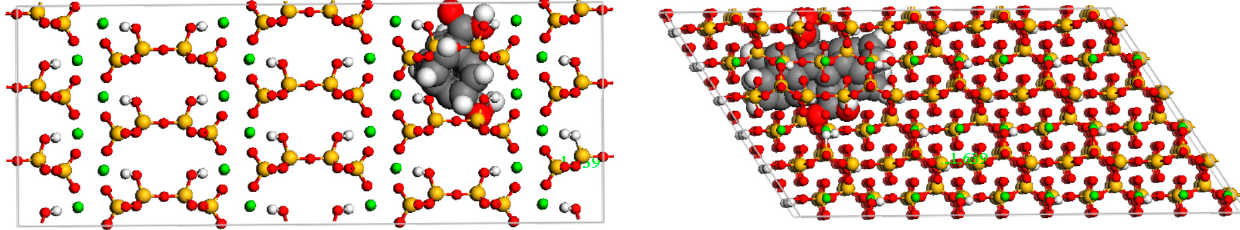
Figure 1. Side ( left ) and top ( right ) view of a SWCNT (2,2), which is functionalized with two COOH groups, embedded in a tobermorite crystal 11 Å. Red: oxygen, Yellow: silicon, Green: calcium, White: hydrogen, Grey: carbon.